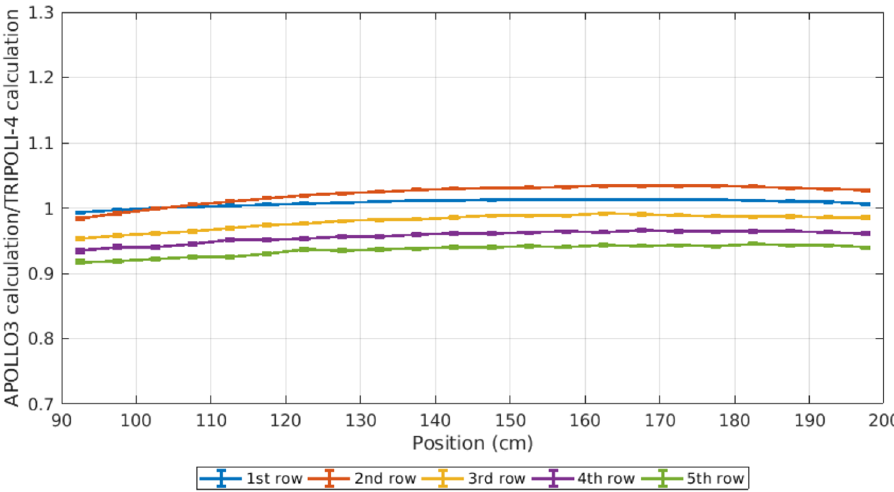
Fig. 28. Comparison between APOLLO3 ® and TRIPOLI-4 ® codes on the production of alpha particles.